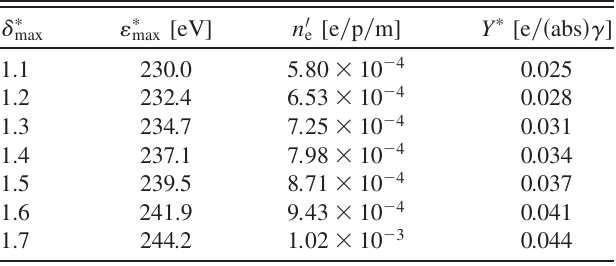
TABLE I. Surface parameters used in the simulation sets. The parameter n 0 e denotes the rate of primary photoelectrons emitted per proton per meter at 7 TeV beam energy, and Y (cid:3) is the associated photoemission yield per absorbed photon. The low- energy electron reflectivity R is taken to be equal to 0.5, unless noted otherwise.